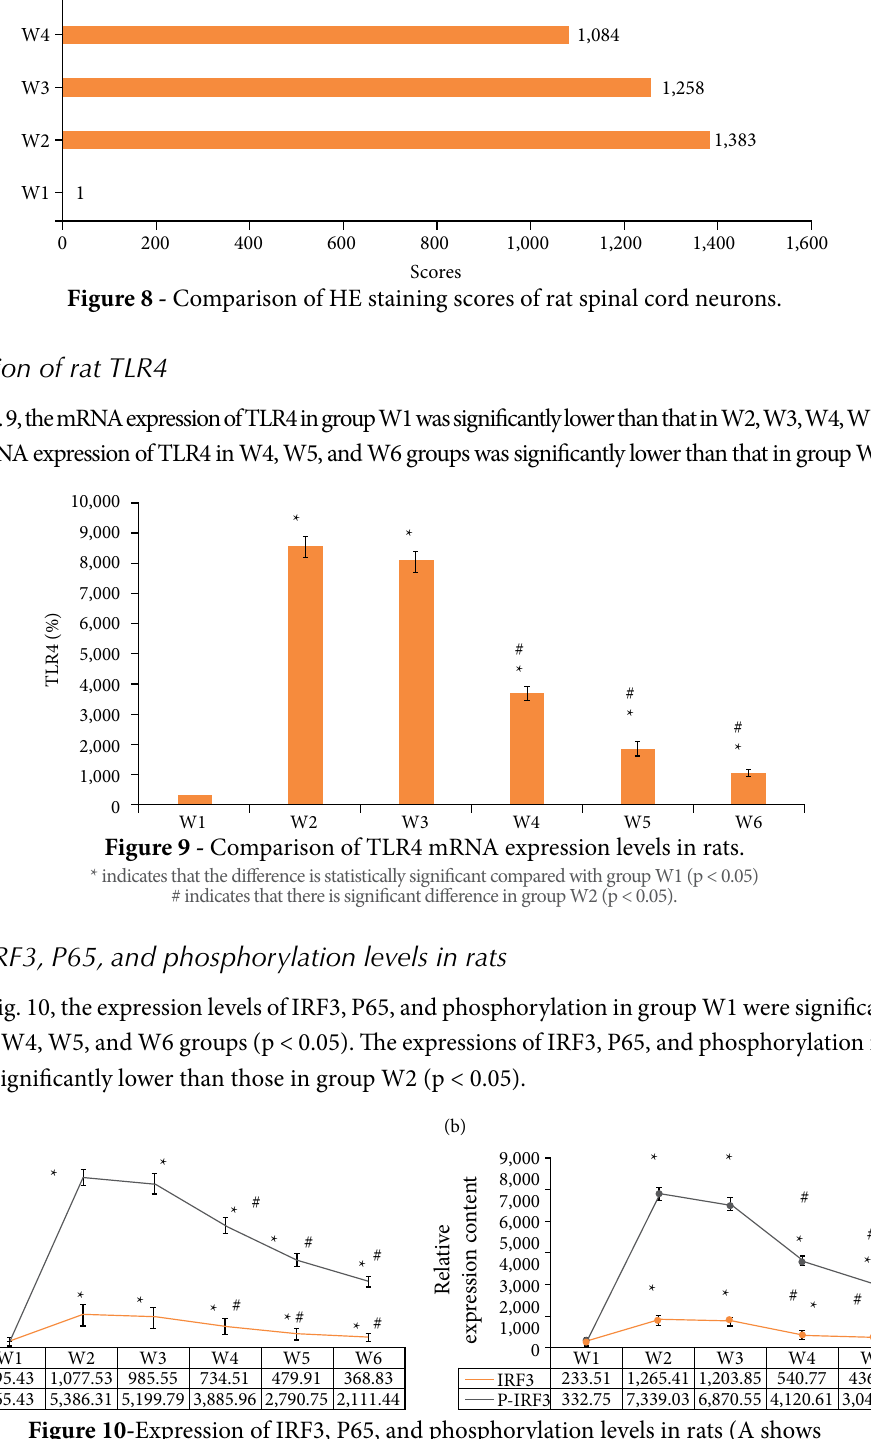
Figure 10- Expression of IRF3, P65, and phosphorylation levels in rats (A shows IRF3 and phosphorylation levels. B is P65 and phosphorylation